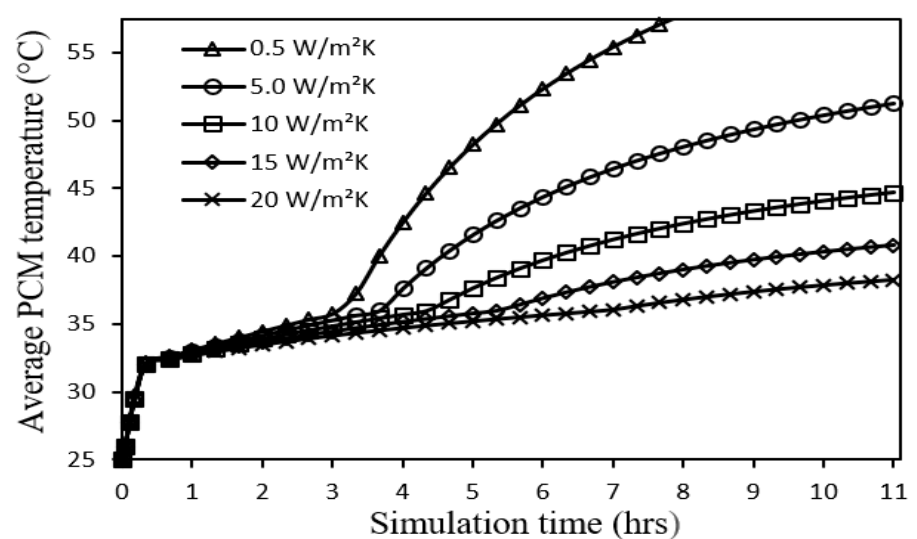
Figure 5. PV cell temperature profiles for different metal foam convective heat transfer coefficients.